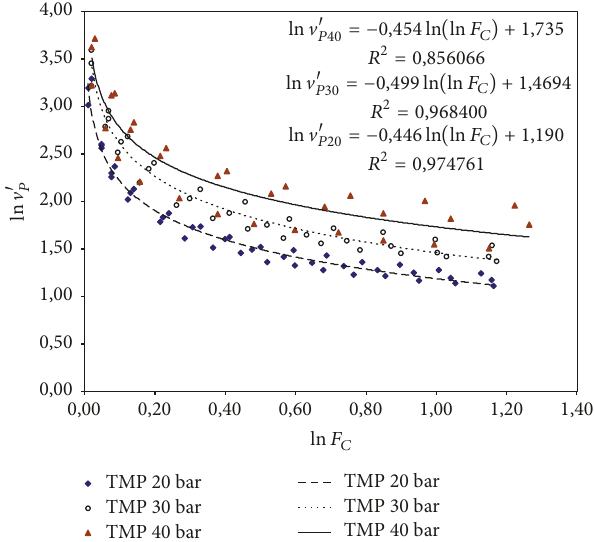
Figure 3: Variation of permeate flux during nanofiltration process at transmembrane pressures of 20, 30, and 40 bar.